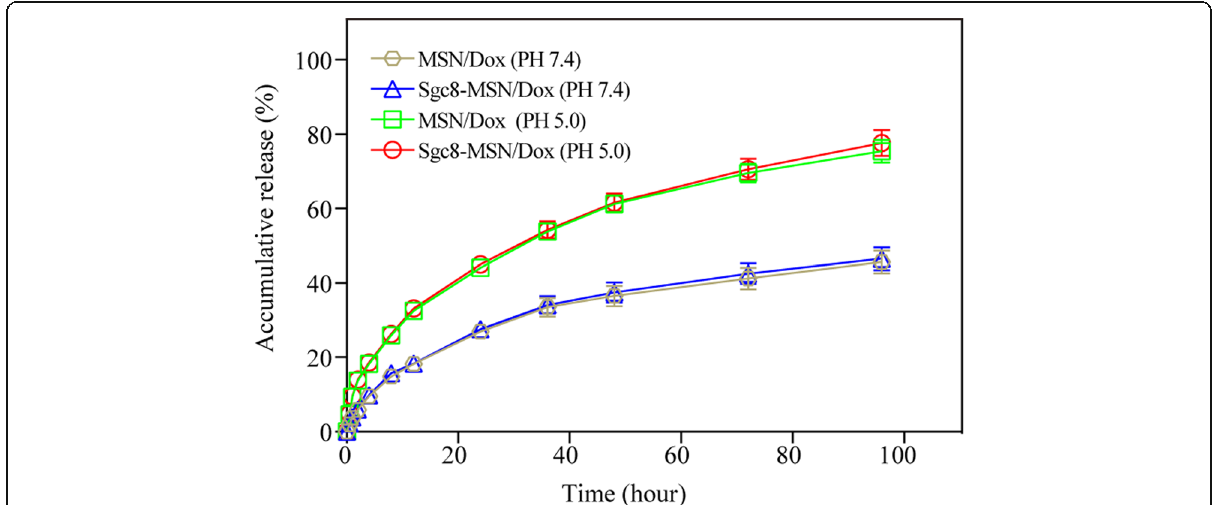
Fig. 4 Release of doxorubicin from Sgc8-MSN/Dox and MSN/Dox in vitro at pH 5.0 or